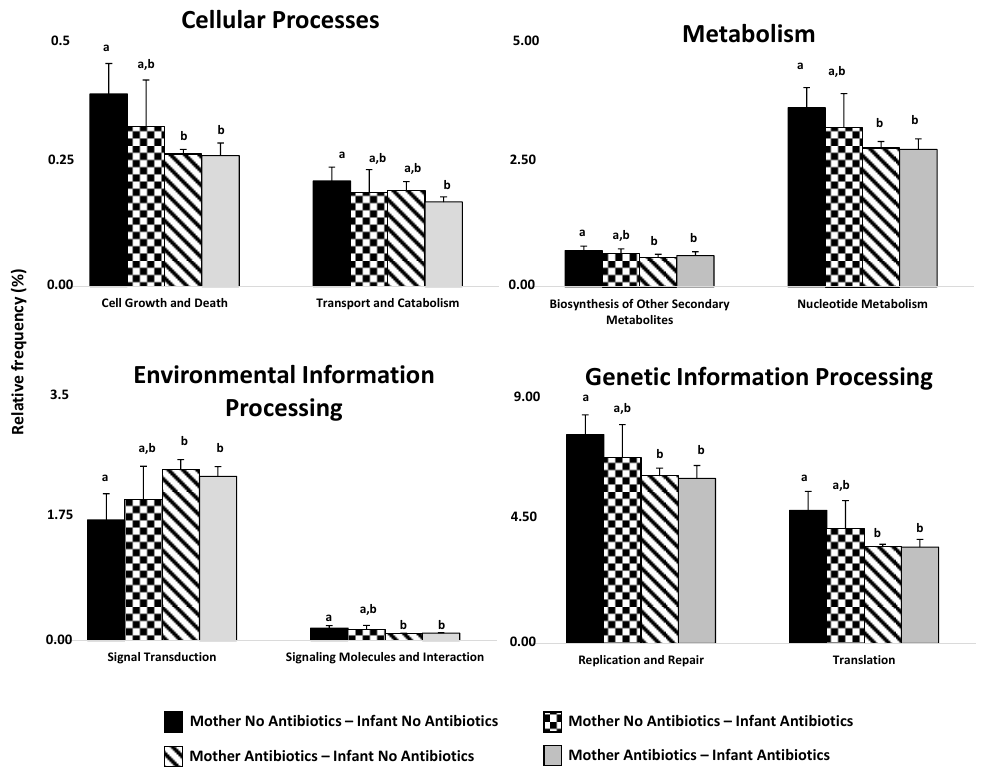
Figure 4. Relative frequencies (mean ± SD) of KEGG pathways (level 2) belonging to the categories that showed statistically significant differences among the four different antibiotic exposure groups at 30 days of life. Different letters above columns within the same KEGG category indicate statistically significant differences ( p < 0.05 and q < 0.25).